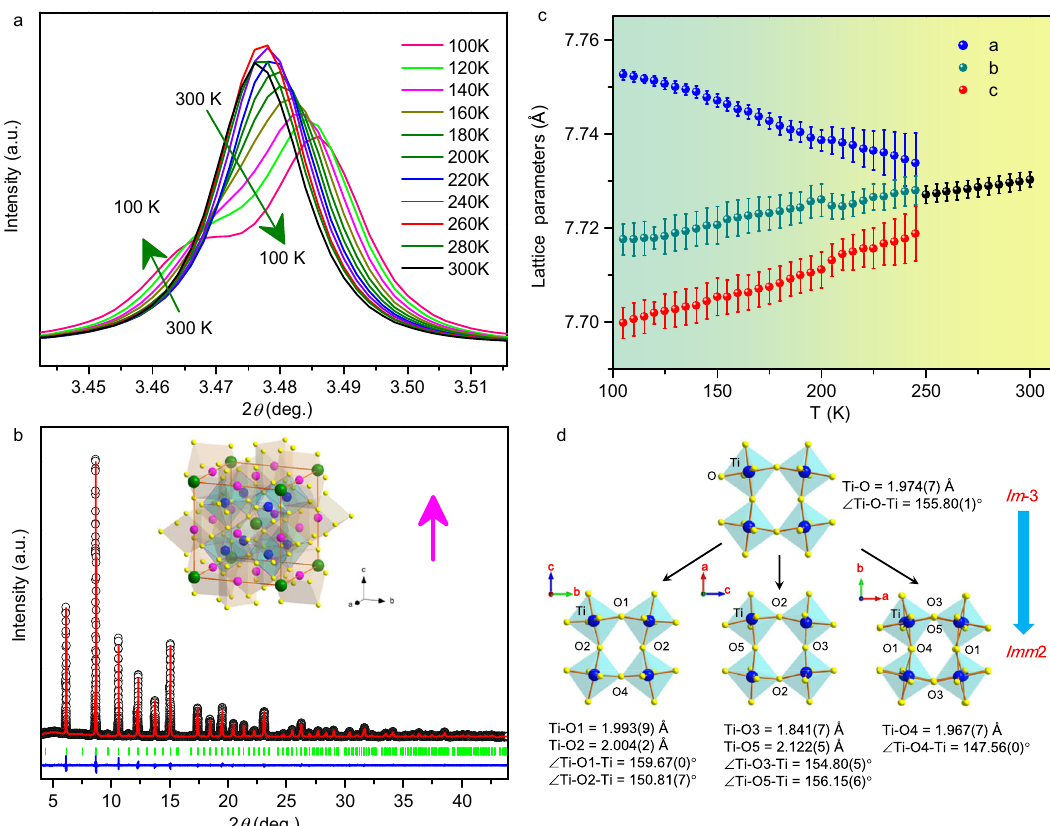
Fig. 5 Temperature induced structural transition in PHTO. a The characteristic diffraction peaks (400) collected at different temperatures. b Rietveld re fi nements based on SXRD data at 90 K. The arrow denotes the polarization direction. c Temperature dependence of the lattice constant and d schematic illustration for the changing of TiO 6 octahedron along different axis.